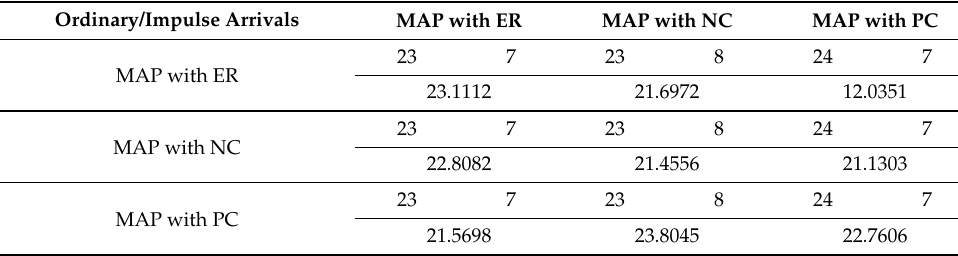
Table 8. Ramification of ordinary and impulse arrival on optimal value.